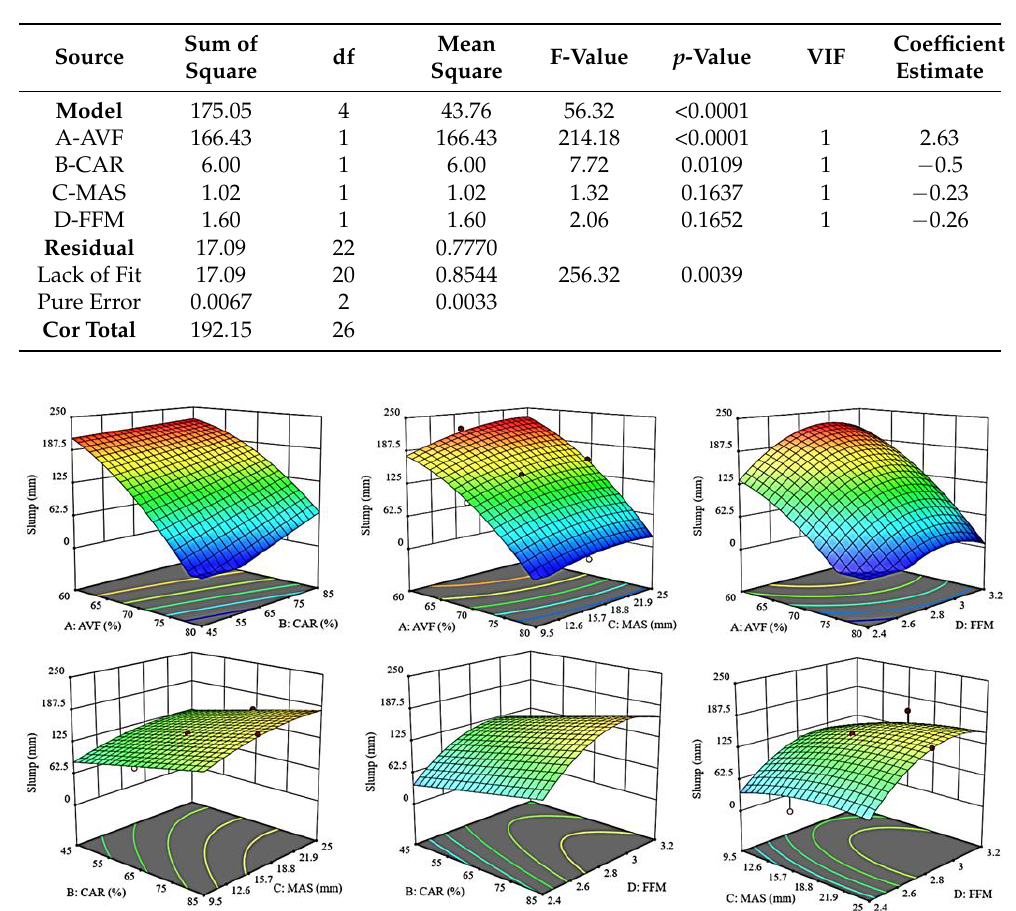
Table A3. MANOVA of air content model.